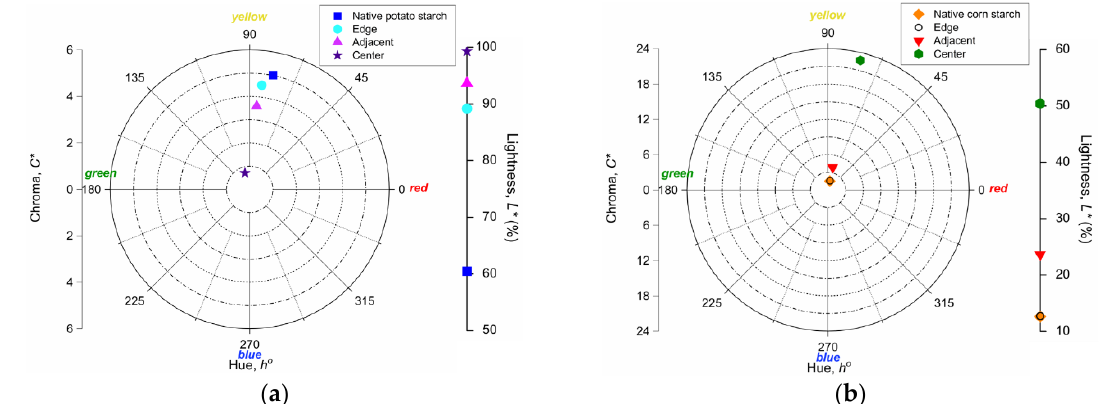
Figure 3. CIE L*C*h° parameters of the investigated samples: ( a ) potato starch and ( b ) corn starch. Figure 3. CIE L*C*h ◦ parameters of the investigated samples: ( a ) potato starch and ( b ) corn In the case of potato starch (Figure 3a), the chroma C * decreased significantly while the hue h° tended to green by moving from the red-yellow quadrant (0 – 90°) to the yellow- green one (90 – 180°) for the sample from the Center. In contrast, for corn starch (Figure 3b), the color saturation C* of the sample from the Center intensified dramatically, and the hue h° practically had only a slight shift to red (~2.5° for the sample from the Center), indicating the red-yellowish color trend.